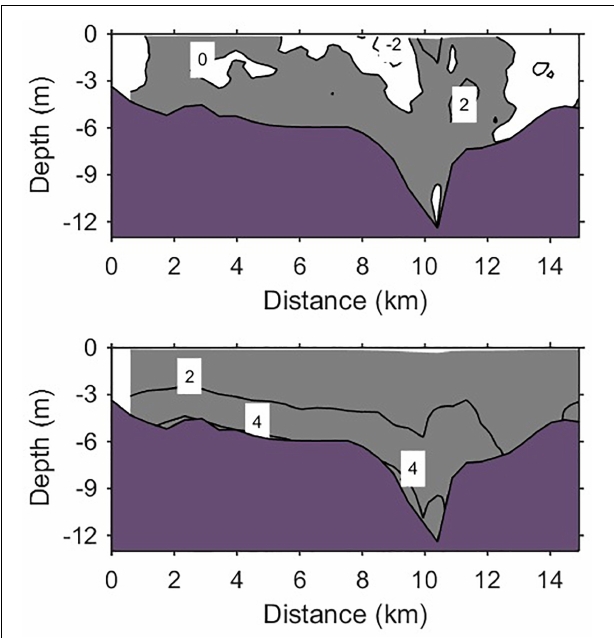
FIGURE 6 | Spring–neap tidal averaged total advection ( × 10 − 5 m 2 /s) (upper panel) and baroclinic pressure ( × 10 − 5 m 2 /s) (lower panel) along the cross-channel section S. Positive value indicates the force toward land. The x-axis represents the distance from the west to the east shoals as one looks into the